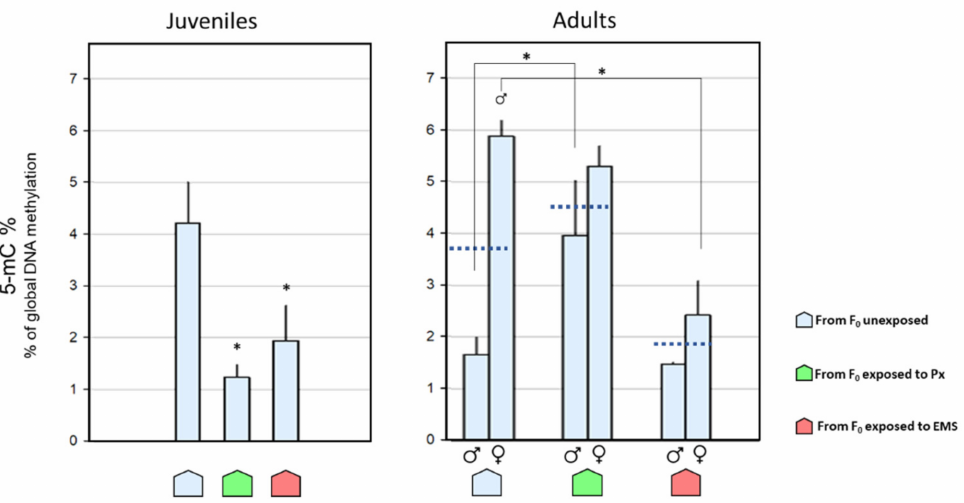
Figure 1. Schematic representation of the experimental design, depicting an intergenerational trial involving the exposure of the red swamp crayfish ( Procambarus clarkii ) to the genotoxicants penox- sulam (Px; green line) and ethyl methanesulfonate (EMS; red line). Sub-trial 1: exposure (7 days) of male ( ) and female ( ) adults, from F 0 , to Px and EMS, in comparison with a control group (blue line). After reproduction of the F 0 organisms (intragroup crosses), F 1 offspring were divided into two sub-trials (2.1 and 2.2). Sub-trial 2.1: the progeny (F 1 ) of each F 0 group was allowed to grow in uncontaminated water until adulthood (blue line); global DNA methylation was analyzed in both stages (juvenile and adult). Sub-trial 2.2: the progeny (F 1 ) of each F 0 group was allowed to grow in uncontaminated water only until the juvenile stage and then exposed to Px and EMS for 7 days, and thereafter analyzed in comparison with a control group. represents the sampling moments.